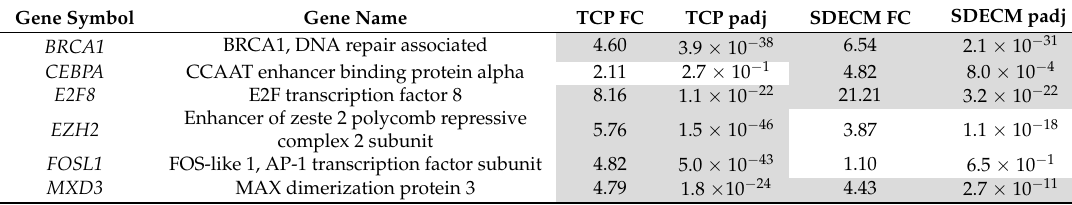
Table 4. Upregulated 1 transcription factors in the COL1A1 gene